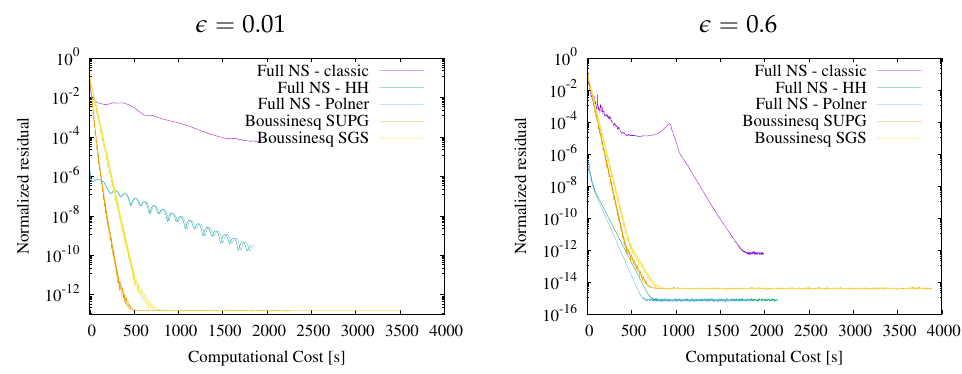
Figure 6. Buoyancy-driven square cavity. Comparative study of residual convergence for various methods.